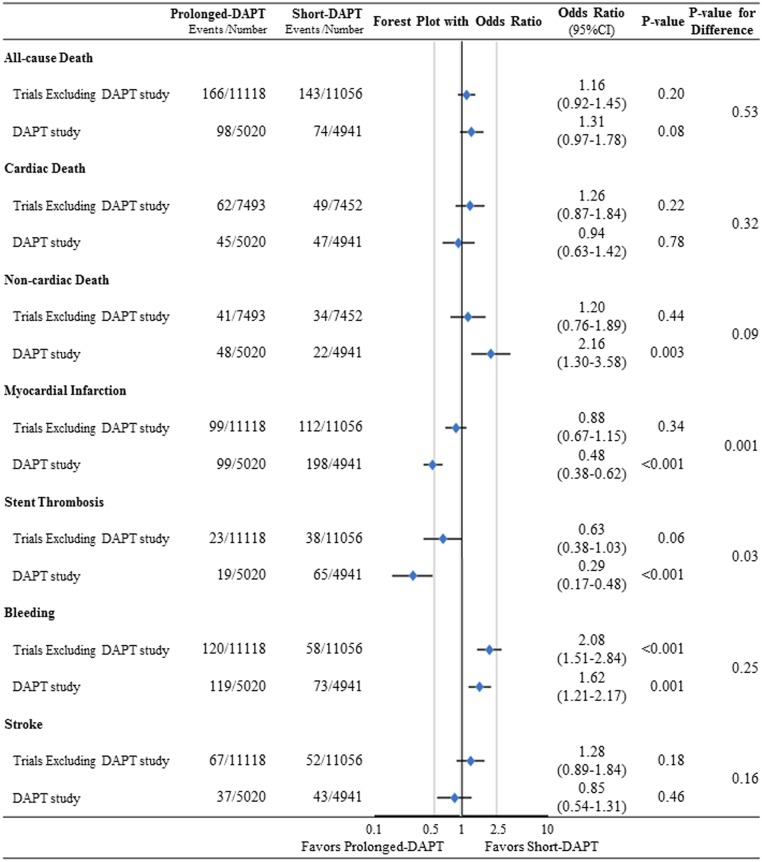
Forest plot with OR of prolonged-DAPT relative to short-DAPT for each clinical outcome for the DAPT trial and the pooled population excluding the DAPT trial.ORs are shown on a logarithmic scale. CI = confidence interval, DAPT = dual anti-platelet therapy, and OR = odds ratio.